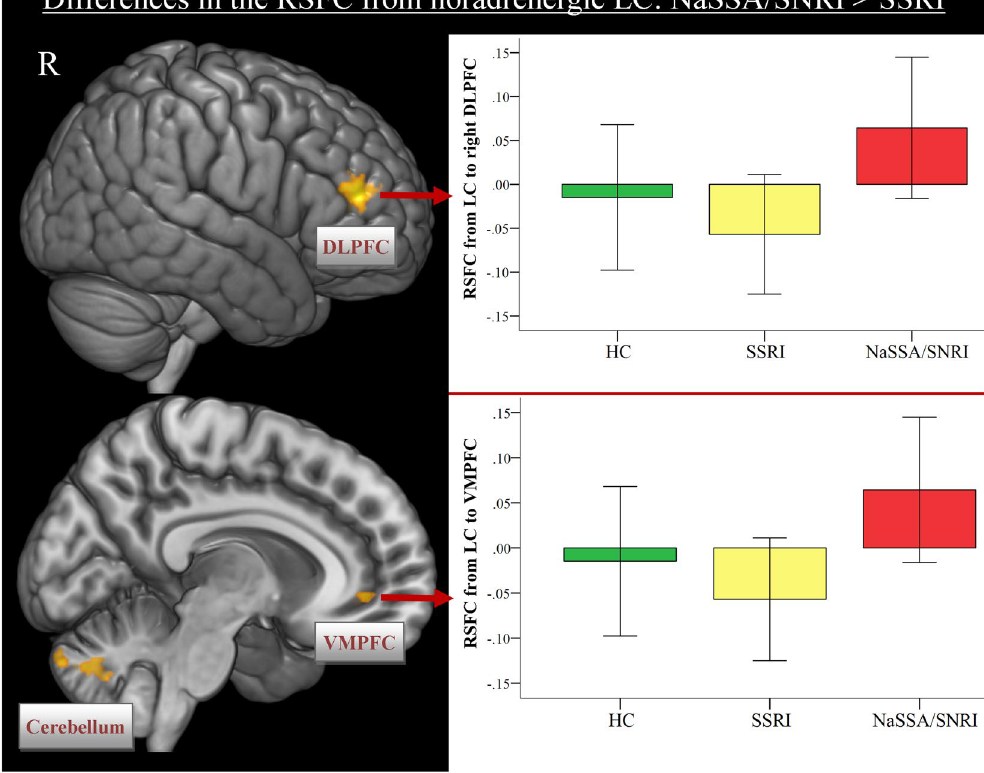
Figure 4. Differences between the classes of antidepressant medication in the whole-brain resting-state functional connectivity maps with seed region in the locus coeruleus (LC). Depressed patients with an SNRI or NaSSA antidepressant demonstrated stronger FC from LC to the DLPFC, VMPFC and cerebellum in contrast to patients taking an SSRI. Abbr.: SSRI, selective serotonin re-uptake inhibitor; SNRI, serotonin and